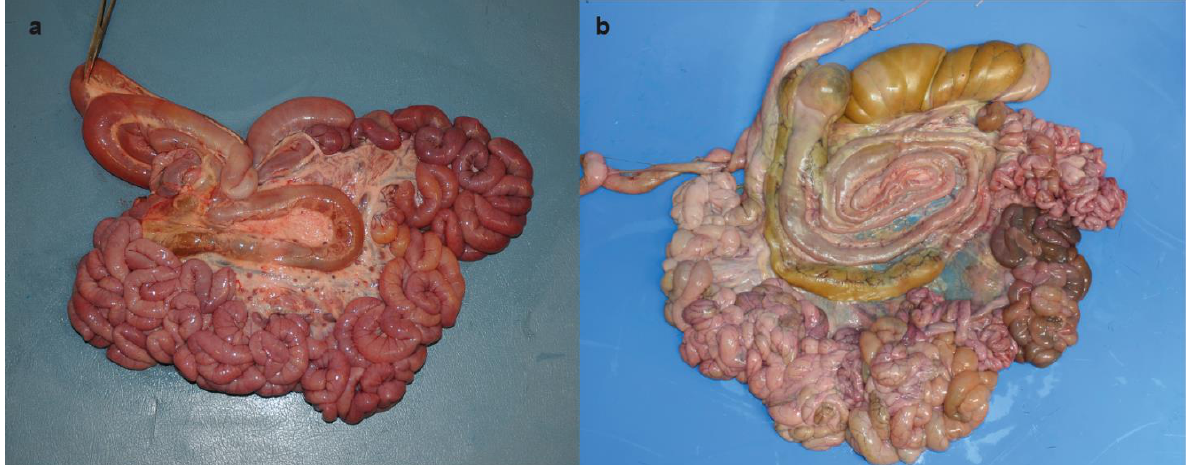
Figure 2. Topography of the spiral loop of the ascending colon. ( a ) Topography of the spiral loop of the ascending colon in the stillborn Romagnola calf with skeletal-cardio-enteric dysplasia. Note the complete displacement of the spiral loop of the ascending colon from the mesojejunum. ( b ) Topography of the spiral loop of the ascending colon in a control. Note the spiral loop of the ascending colon located at the middle of the